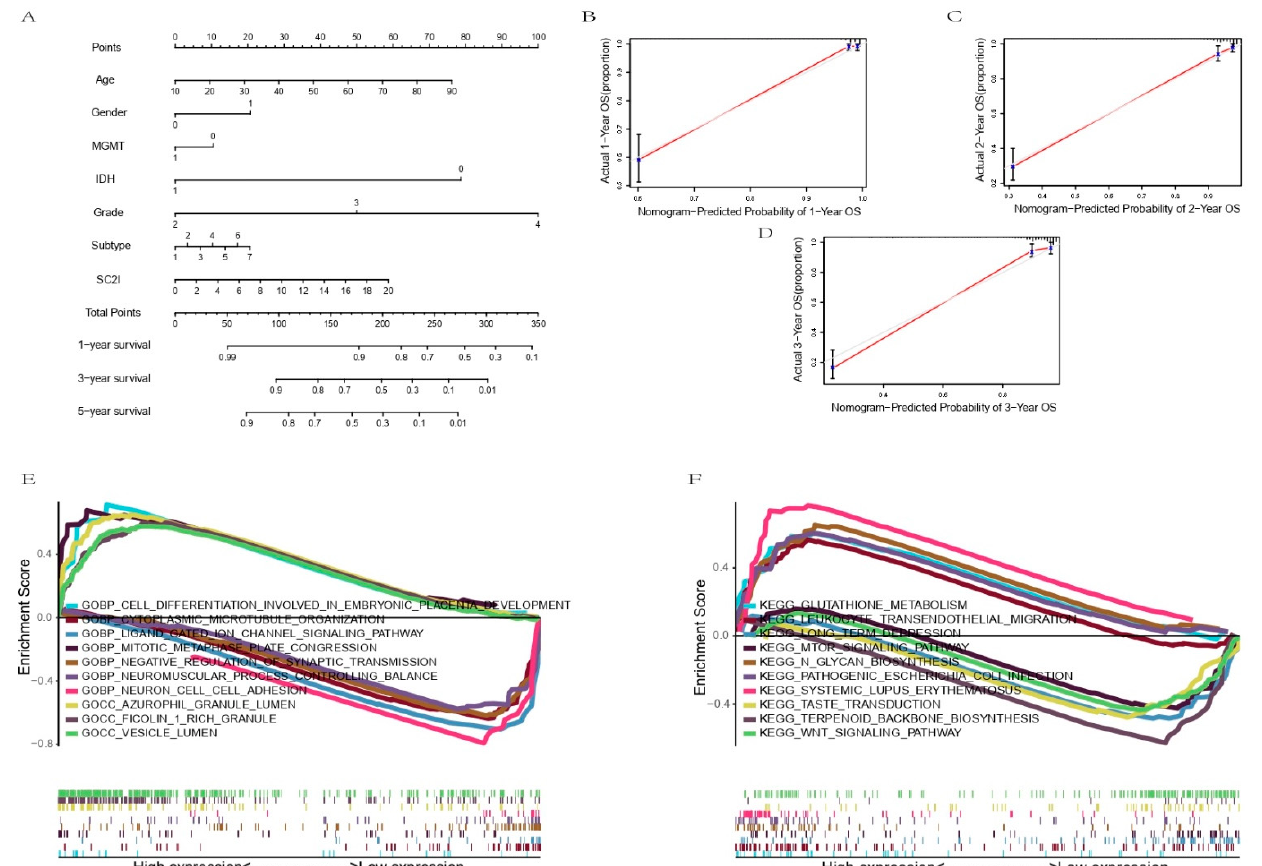
Figure 5. Prediction of the survival of glioma patients by nomogram, and GSEA analysis between different risk groups in TCGA cohort. ( A ) Nomogram used for predicting glioma patients was constructed. ( B – D ) Calibration plots for predicting 1-, 2- and 3-year overall survival. ( E , F ) GO and KEGG functional enrichment analysis. GSEA, gene set enrichment analysis; TCGA, The Cancer Genome Atlas; GO, gene ontology; KEGG, Kyoto encyclopedia of genes and genomes.